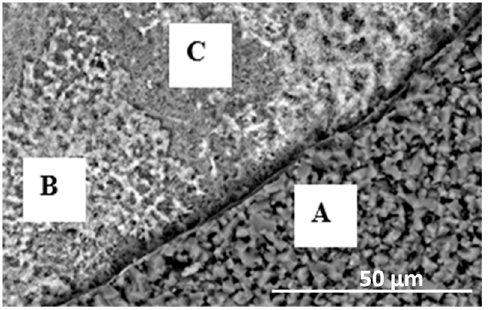
Figure 12. Surface of Ti-46Al-7Nb-0.7Cr-0.1Si-0.2Ni alloy after spallation of the basic layer of oxidation products (prepared by grinding). The structures of products in fields A, B and C are shown in Figure 13.